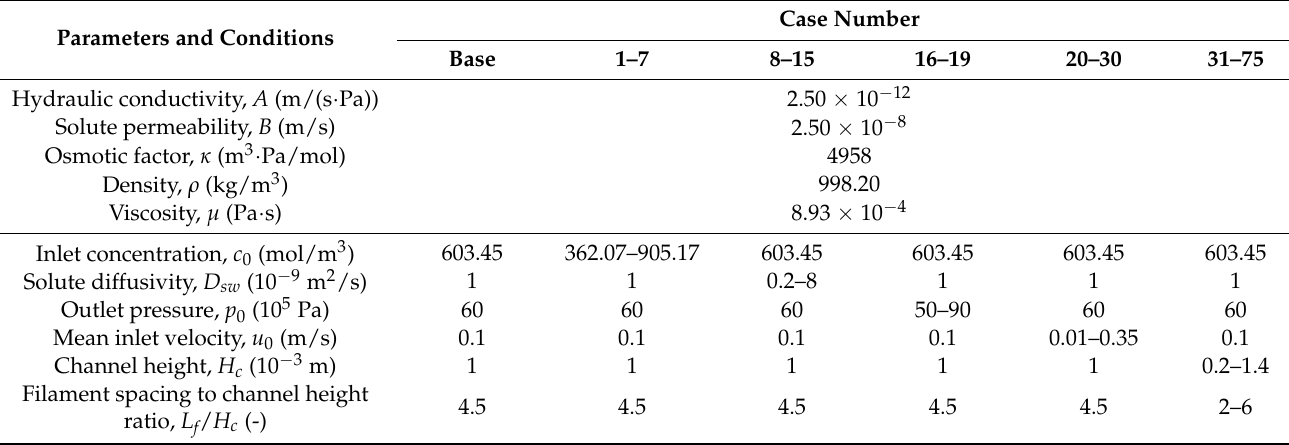
Table 1. Model parameters and simulation conditions where inlet concentration c 0 , solute diffusivity in water D sw , outlet pressure p 0